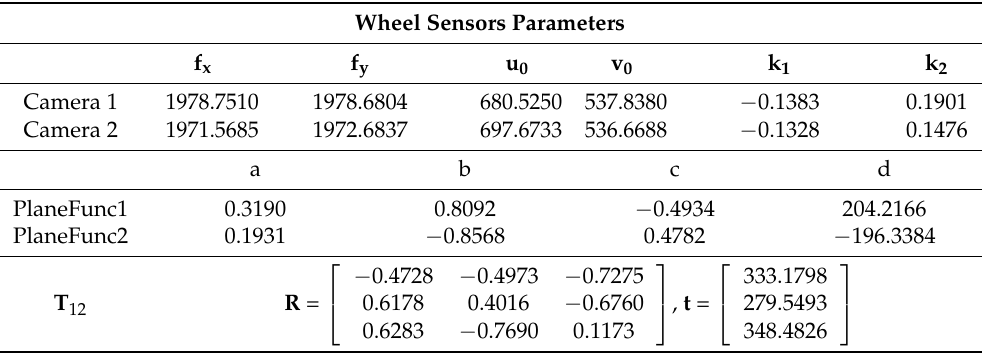
Figure 12. Wheel size measurement system in an outdoor complex environment. Table 1. Calibration parameters of wheel sensors.